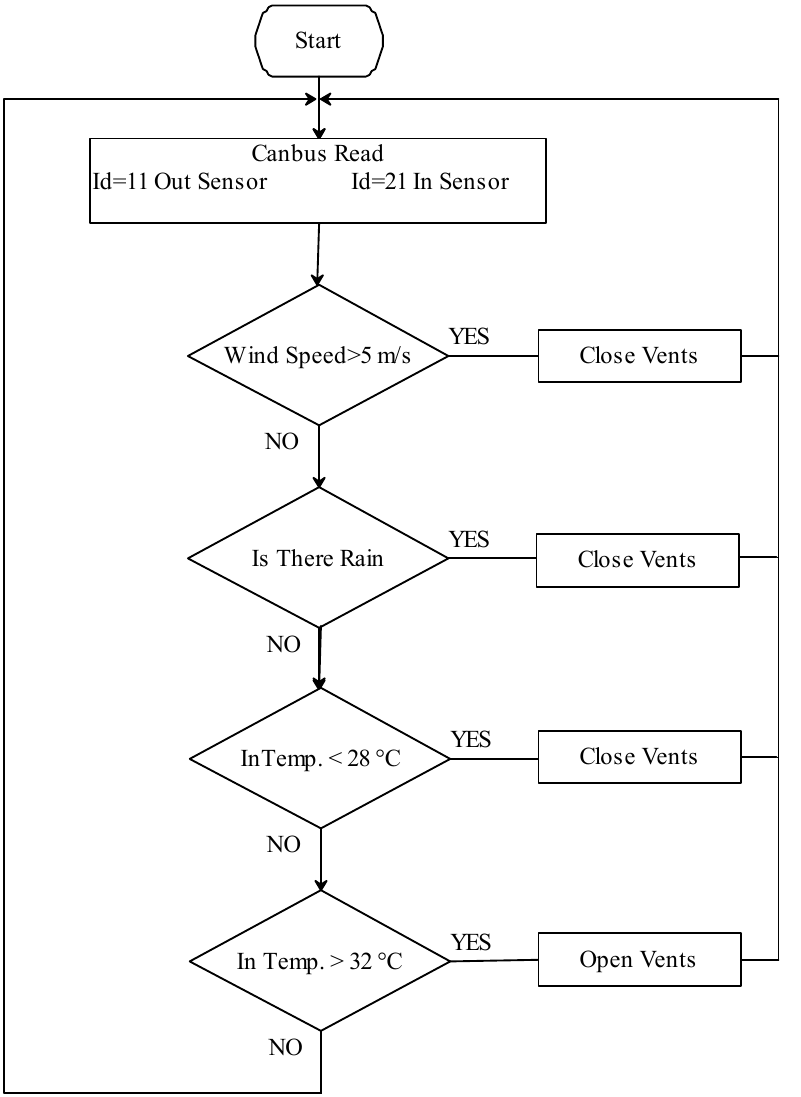
Figure 20. Automatic greenhouse air conditioning algorithm.